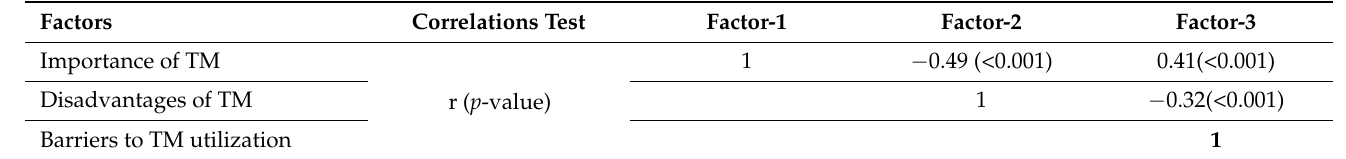
Table 4. Divergent validity of the PTIDB